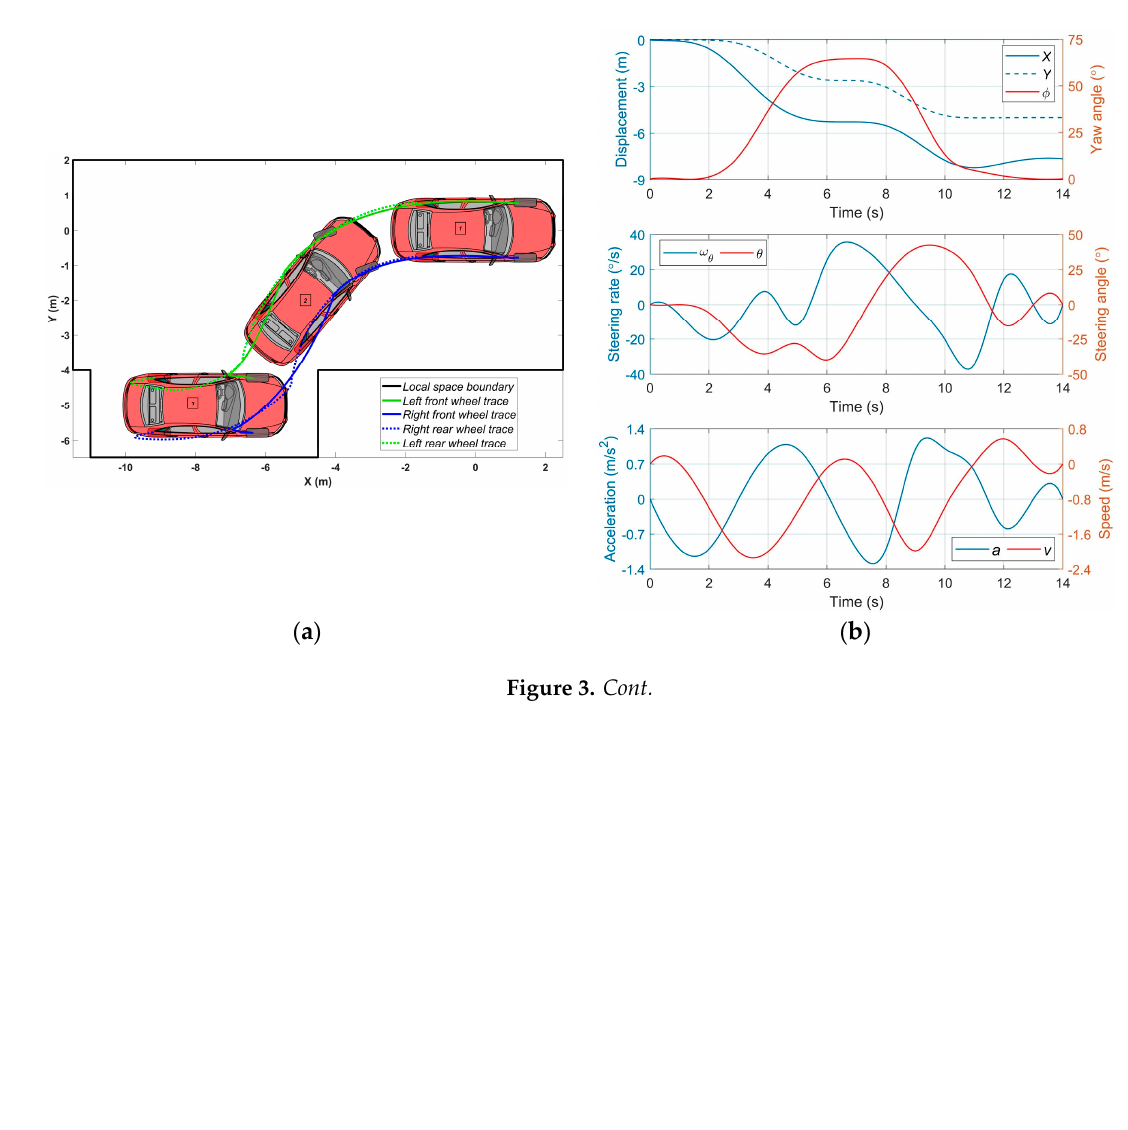
( d ) Figure 3. Simulation results for reverse parking of a passenger car: ( a ) Position and trajectory (parallel reverse); ( b ) Basic parameters (parallel reverse); ( c ) Position and trajectory (perpendicular reverse); ( d ) Basic parameters (perpendicular reverse).